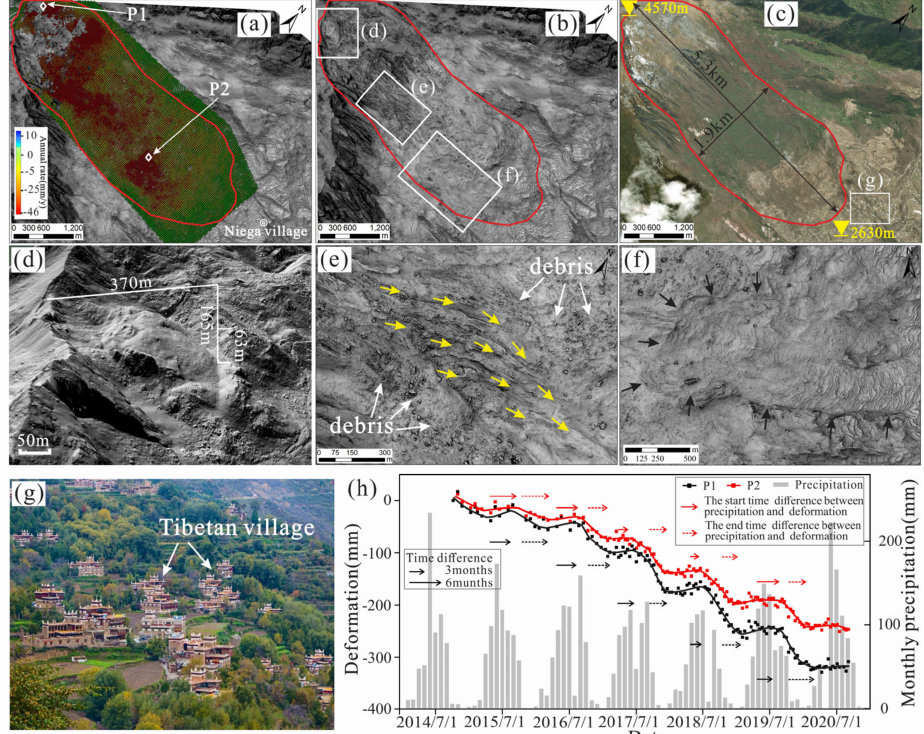
Figure 6. The Gaoding landslide in Niega Town and the relationship between its time-series defor- mation and rainfall: ( a ) InSAR-acquired annual average deformation rate of the Gaoding landslide; ( b ) airborne LiDAR-SVF image; ( c ) optical image; ( d ) local landslide at the rear edge of the Gaoding landslide; ( e ) strong deformation in the middle of the Gaoding landslide, with yellow arrows showing the landslide movement path; ( f ) a strongly deformed area on the right side of the front edge of the Gaoding landslide, with black arrows indicating the local sliding boundary; ( g ) Jiaju Tibetan Village; ( h ) time-series deformation at Points P1 and P2 against monthly